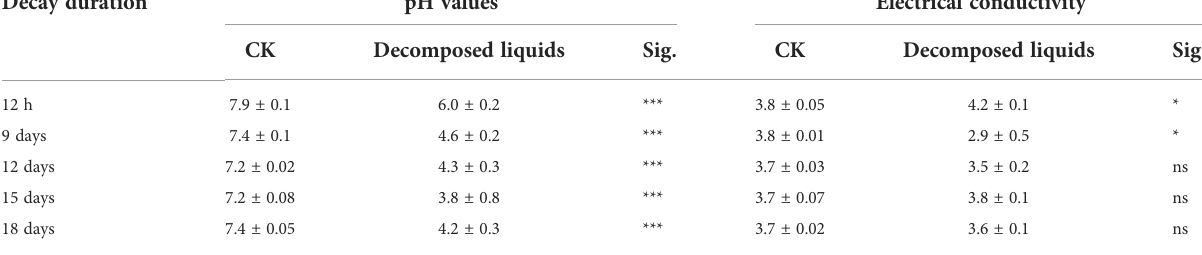
TABLE 1 pH values and electrical conductivity of CK and decomposition leachates from different decay durations. Decay